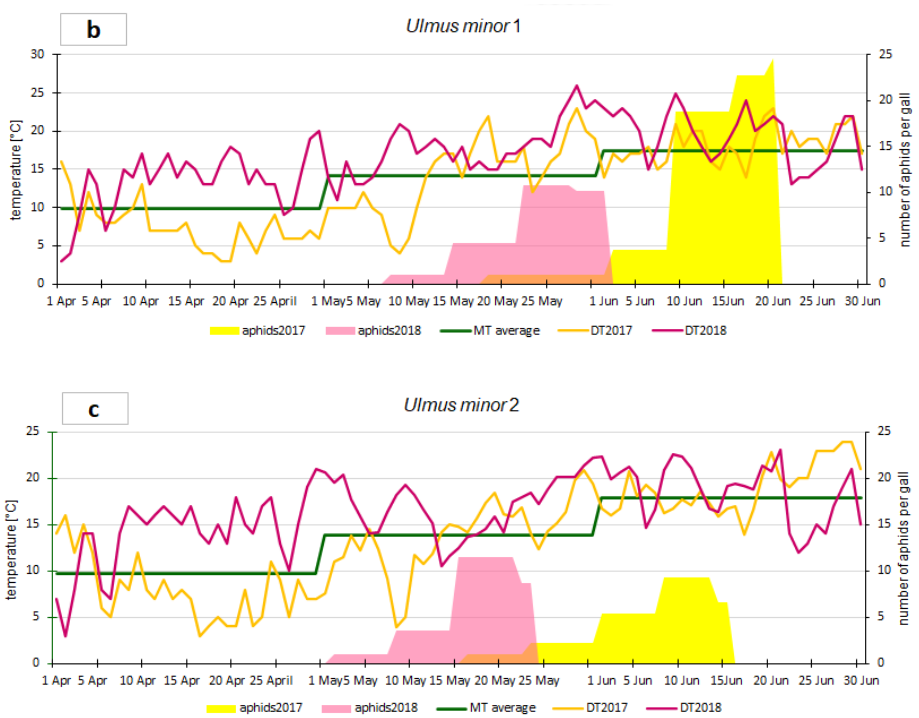
Figure 2. The dynamics of T. nigriabdominalis abundance on U. glabra ( a ) and U. minor ( b ), and ( c ) in relation to temperature. U. minor 1 ( study area in Poznań ), U. minor 2 (study area in Rzeszów); aphids: average number of aphids per gall. MT: average monthly air temperature; DT: average daily air temperature.